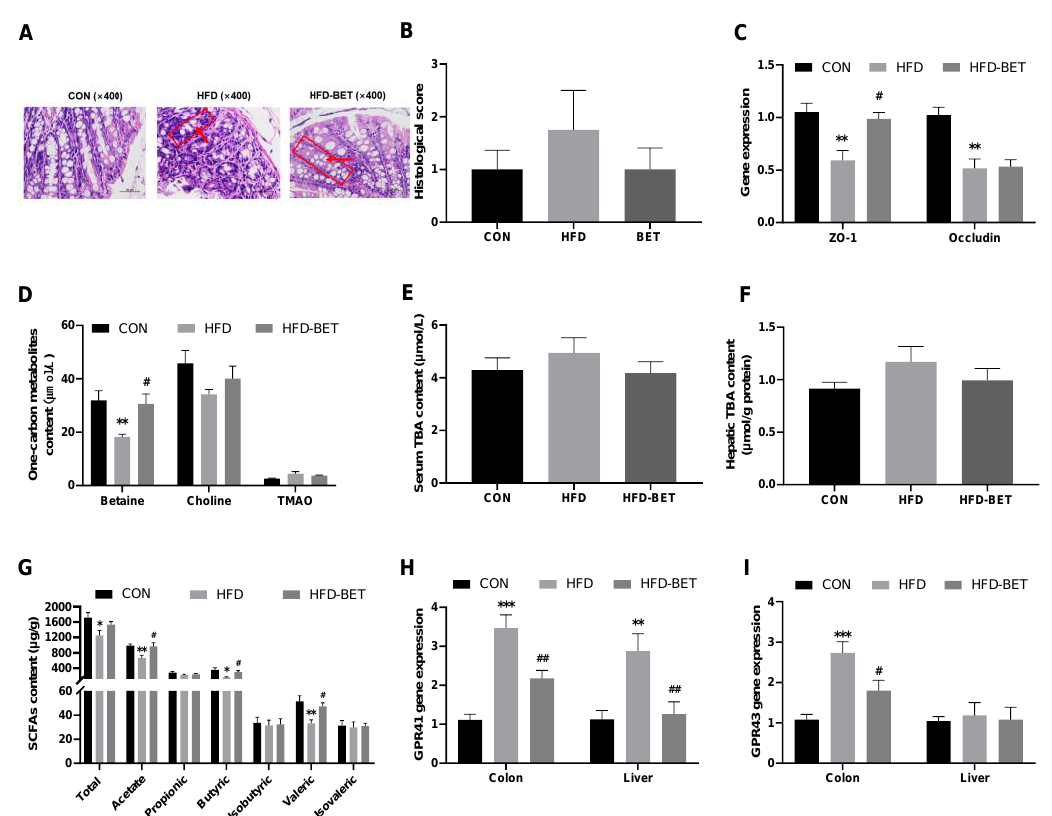
Figure 3. Effects of maternal betaine supplementation on intestinal barrier integrity and levels of gut flora-related metabolites. ( A ) Hematoxylin–eosin (H&E)-stained colon sections; the red box refers to a crypt, and the red arrow refers to a goblet cell; ( B ) histopathological score of colon; ( C ) the mRNA expression of ZO-1 and Occludin in the colon; ( D ) one-carbon metabolites content in the serum; ( E ) TBA content in the serum; ( F ) TBA content in the liver; ( G ) SCFAs content in the cecal; ( H , I ) the mRNA expression of GPR41/43 in the colon and liver. Data are presented as the means ± SEM. * p < 0.05, ** p < 0.01 and *** p < 0.001 for the HFD group vs. the CON group; # p < 0.05 and ## p < 0.01 for the HFD-BET group vs. the HFD group. Abbreviation: CON group, control diet group; HFD group, high-fat diet group; HFD-BET group, high-fat diet + 1% betaine group; TMAO, trimethylamine-n-oxide; TBA, total bile acid; SCFAs, short-chain fatty acids.